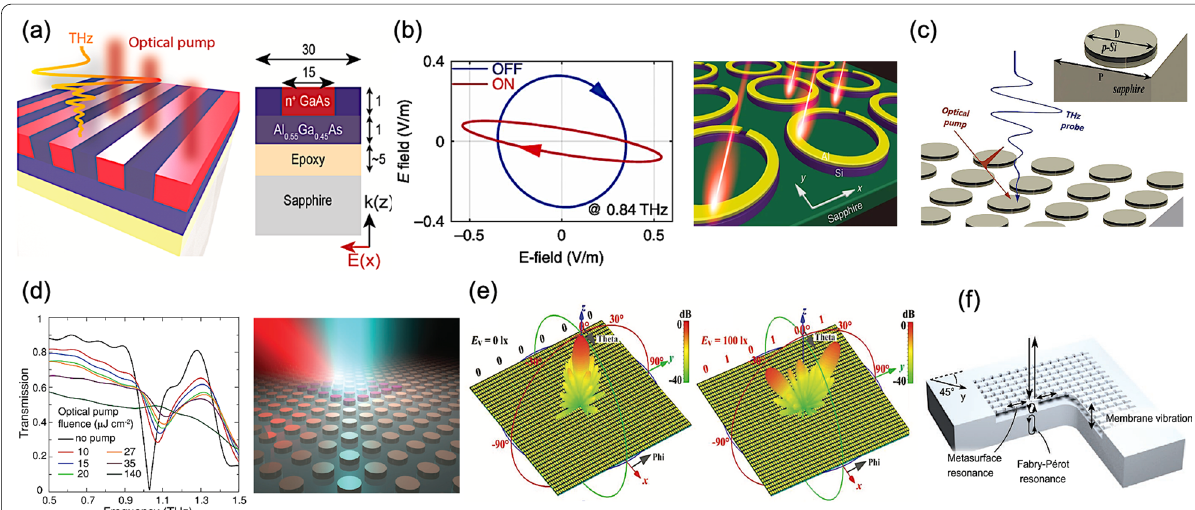
Fig. 5 Optically reconfigurable and tunable metasurfaces a Transient GaAs metasurface induced by a structured femtosecond optical pump beam [78], b Calculated two output polarization ellipses in the “ON” and “OFF” states (left), Active control of anisotropy in h ‑SRR metasurface (right) [79], c Plasmonic metasurface controlled by an optical‑pump terahertz‑probe spectroscopy [80], d Measured transmission coefficient for different values of the optical fluence (left), All‑dielectric metasurface pumped by an ultrafast laser beam (right) [81], e Simulated reflection beams of the light‑controlled digital coding metasurface at 3.75 GHz with different coding sequences [82], and f Optomechanics of a chiral metasurface consisting of a semiconductor membrane patterned with L‑shaped holes